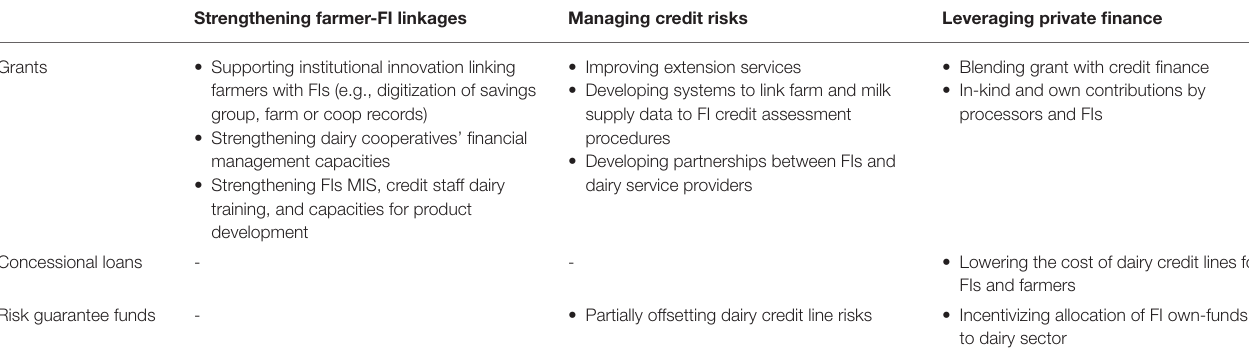
TABLE 6 | Potential roles of climate finance in catalyzing investment in the dairy sector by financial